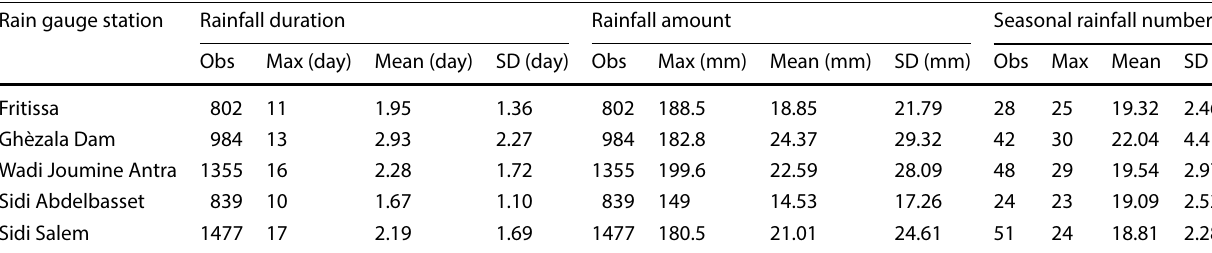
Table 11 Descriptive statistics of selected variables of rainfall spell